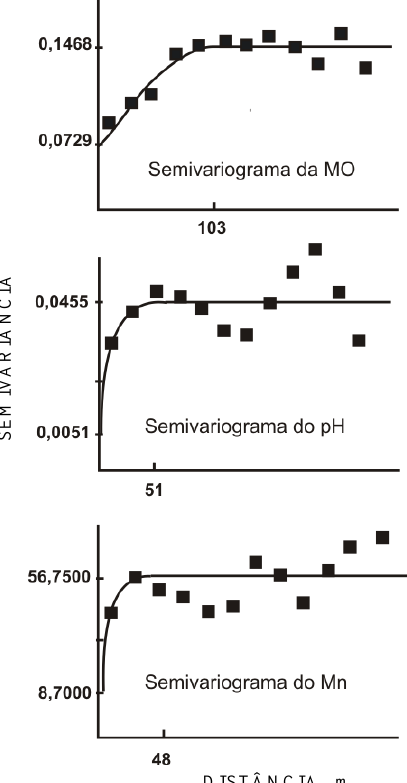
Figura 1. Semivariogramas de teor de matéria